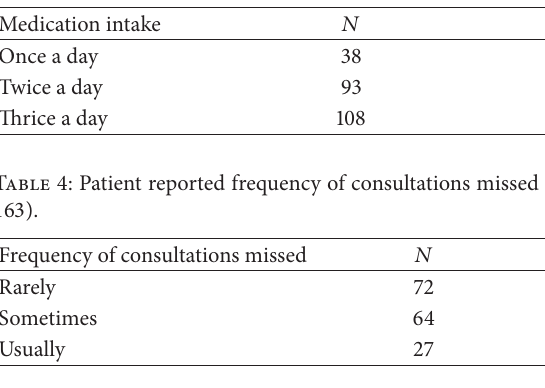
Table 3: Recommended frequency of medication intake ( 𝑁 = 239 ).